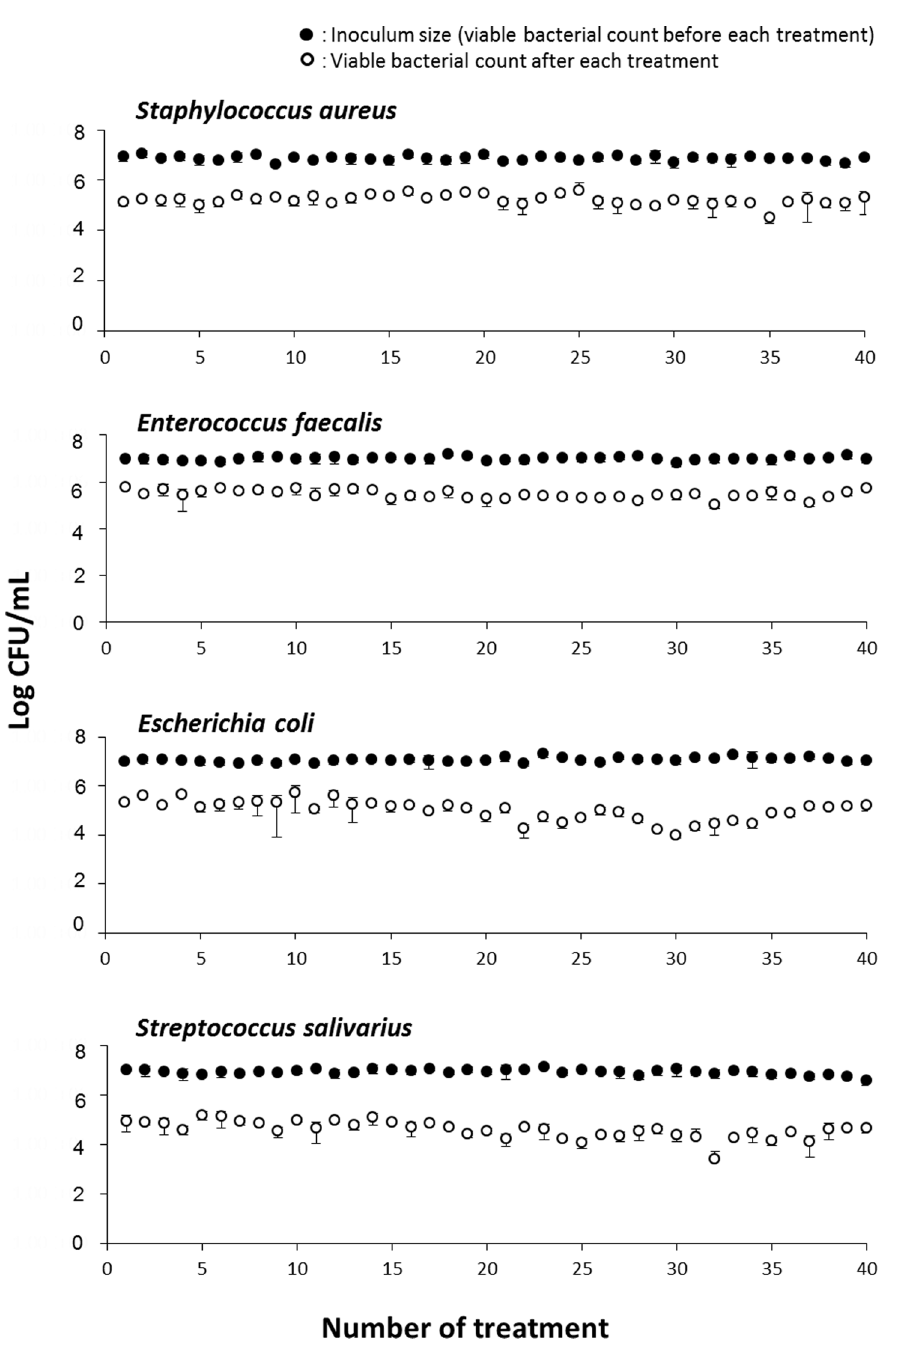
Figure 3. Changes in the antibacterial effect of disinfection treatment with photolysis of H 2 O 2 in four bacteria. Staphylococcus aureus , Enterococcus faecalis , Escherichia coli , and Streptococcus salivarius were exposed 40 times to disinfection treatment. Each value represents the mean 6 standard deviation (n=3).